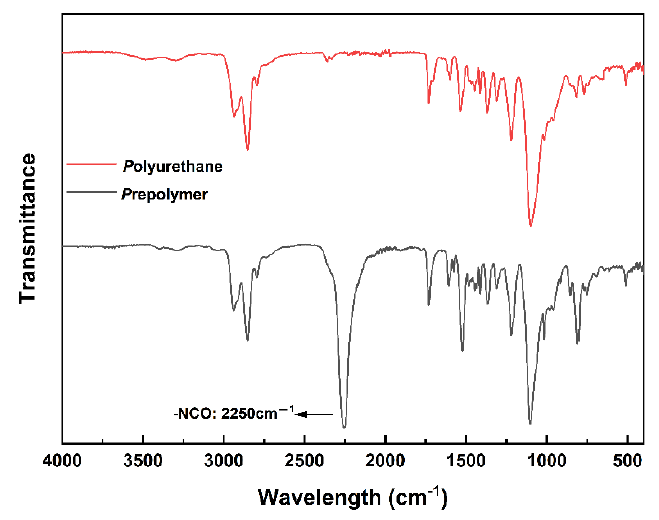
Figure 4. FTIR spectrum of prepolymer and reacted polyurethane after DSC testing.